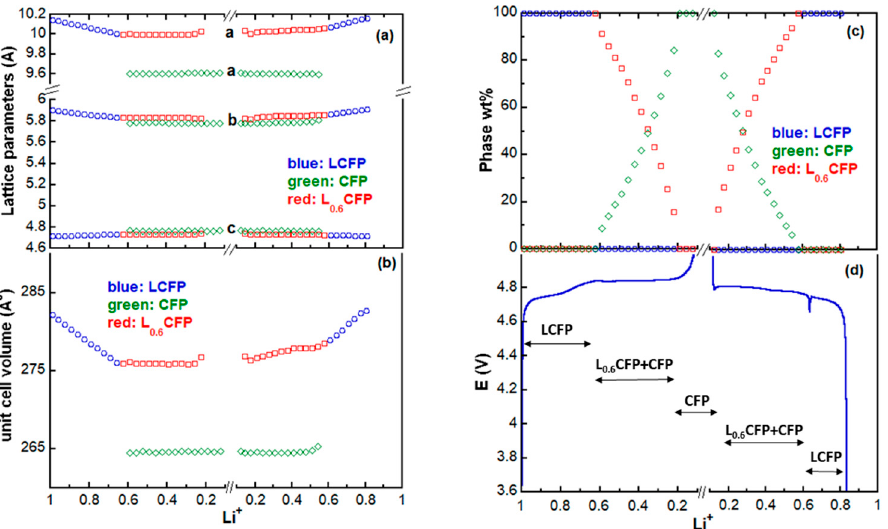
Figure 5. Variation of lattice parameters in cycle B: ( a ) lattice parameters; ( b ) unit cell volumes; ( c ) phase wt.% and ( d ) cell potential vs. the Li content during the charge/discharge process.